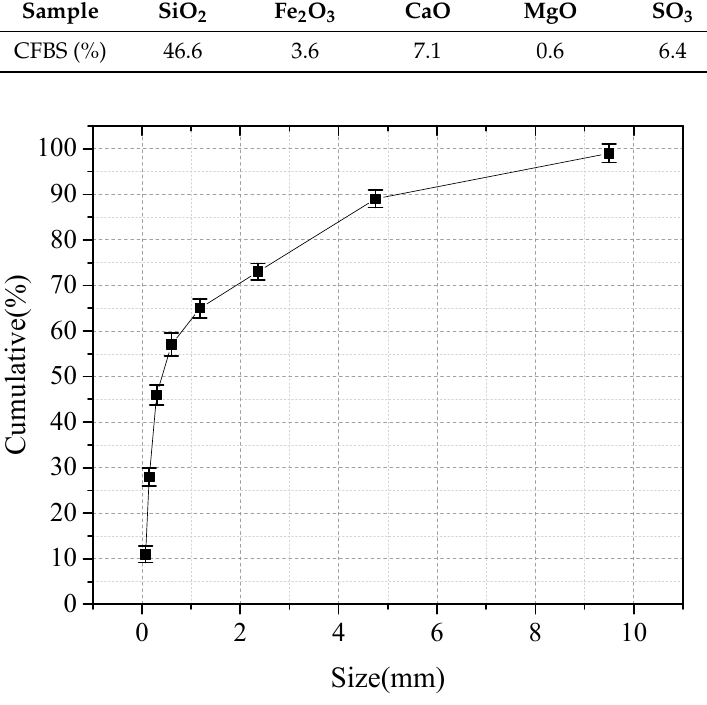
Figure 2. Particle characteristics of CFBS. Table 1. Chemical composition of CFBS/%. Table 2. Properties of cement used.